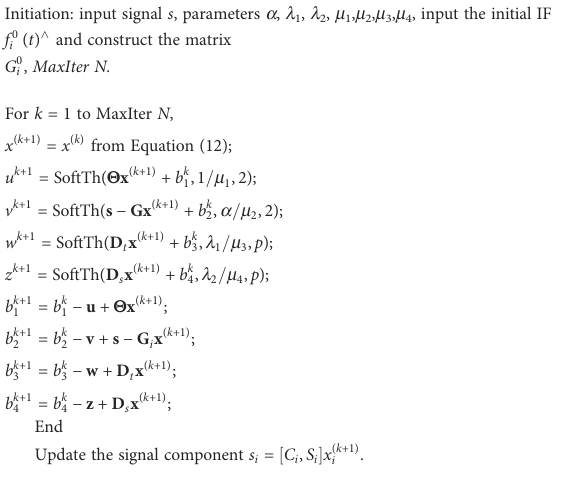
TABLE 1 The proposed STNP-ACMD algorithm. Algorithm 1. The proposed STNP-ACMD